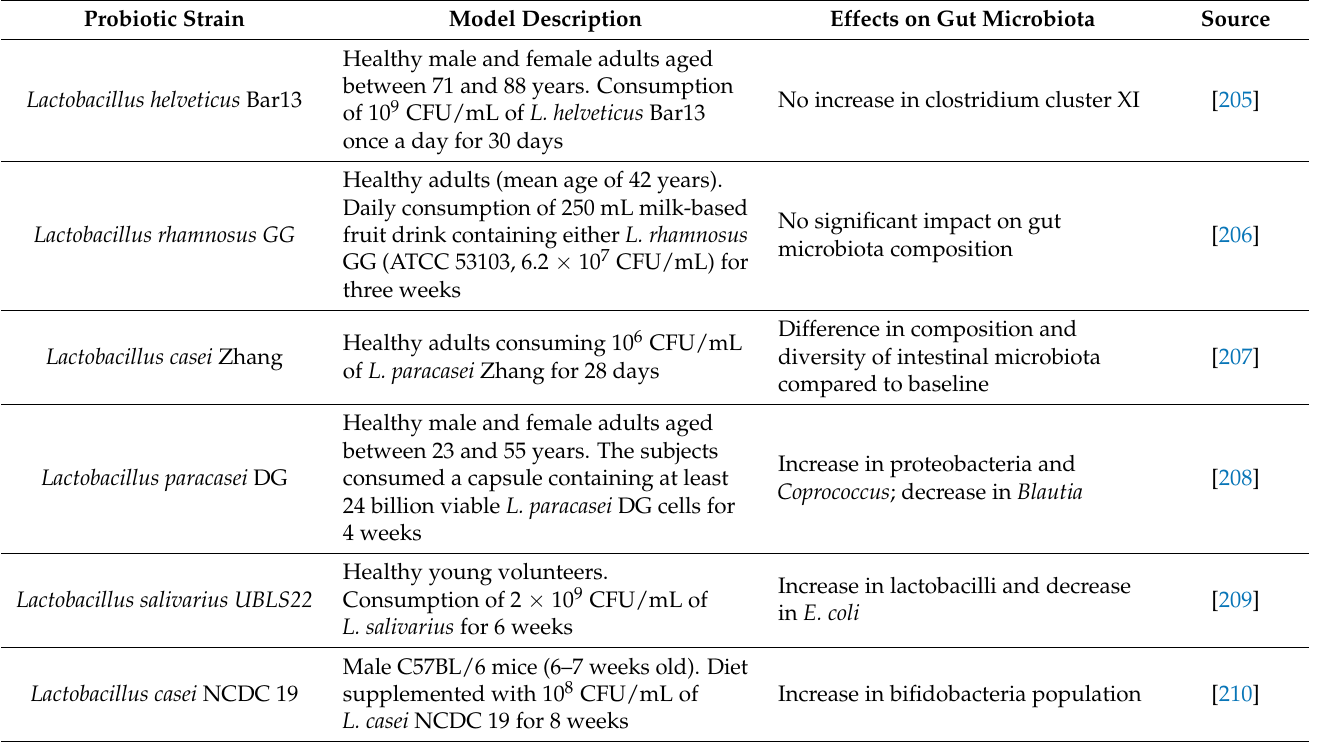
Table 1. Probiotics and effects on gut